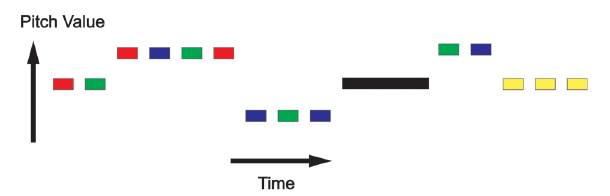
FIGURE 2 | Repetition suppression paradigm. Stimuli were presented in epochs with periods of silence in between. Within each epoch, stimuli were presented in “pitch-trains” or “noise-trains,” where a pitch-train contained between 1 and 6 stimuli of the same pitch, and noise-trains contained between 1 and 6 noise stimuli. Colors indicate the various types of pitch train: Random Interval Noise (RIN) (red), Harmonic Complex (HC) (green), Click Train (CT) (blue), and noise (yellow). The black rectangle represents a period of silence.